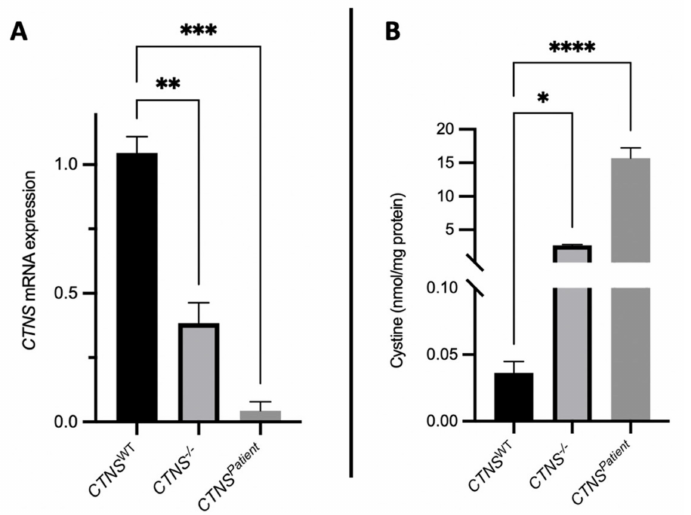
Figure 5. Cystine accumulation and CTNS expression in kidney tubules. Real-time PCR quantification showed significant reduction of CTNS gene expression in both cystinotic tubule models when compared to the healthy control ( A ), which led to an increase in cystine accumulation in the cystinotic kidney tubules ( B ). One-way ANOVA statistical analysis was performed (N = 3; * p -value < 0.05; ** p -value < 0.01; *** p -value < 0.001; **** p -value <